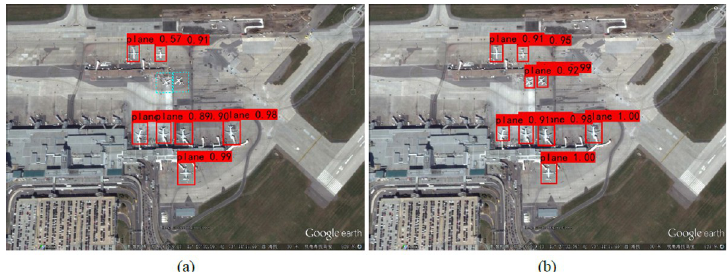
Fig 10. Test results of YOLOv3 and SR-YOLO. The cyan box indicates the missed plane object. (a) Results of YOLOv3 algorithm detection; (b) Results of SR-YOLO algorithm detection.